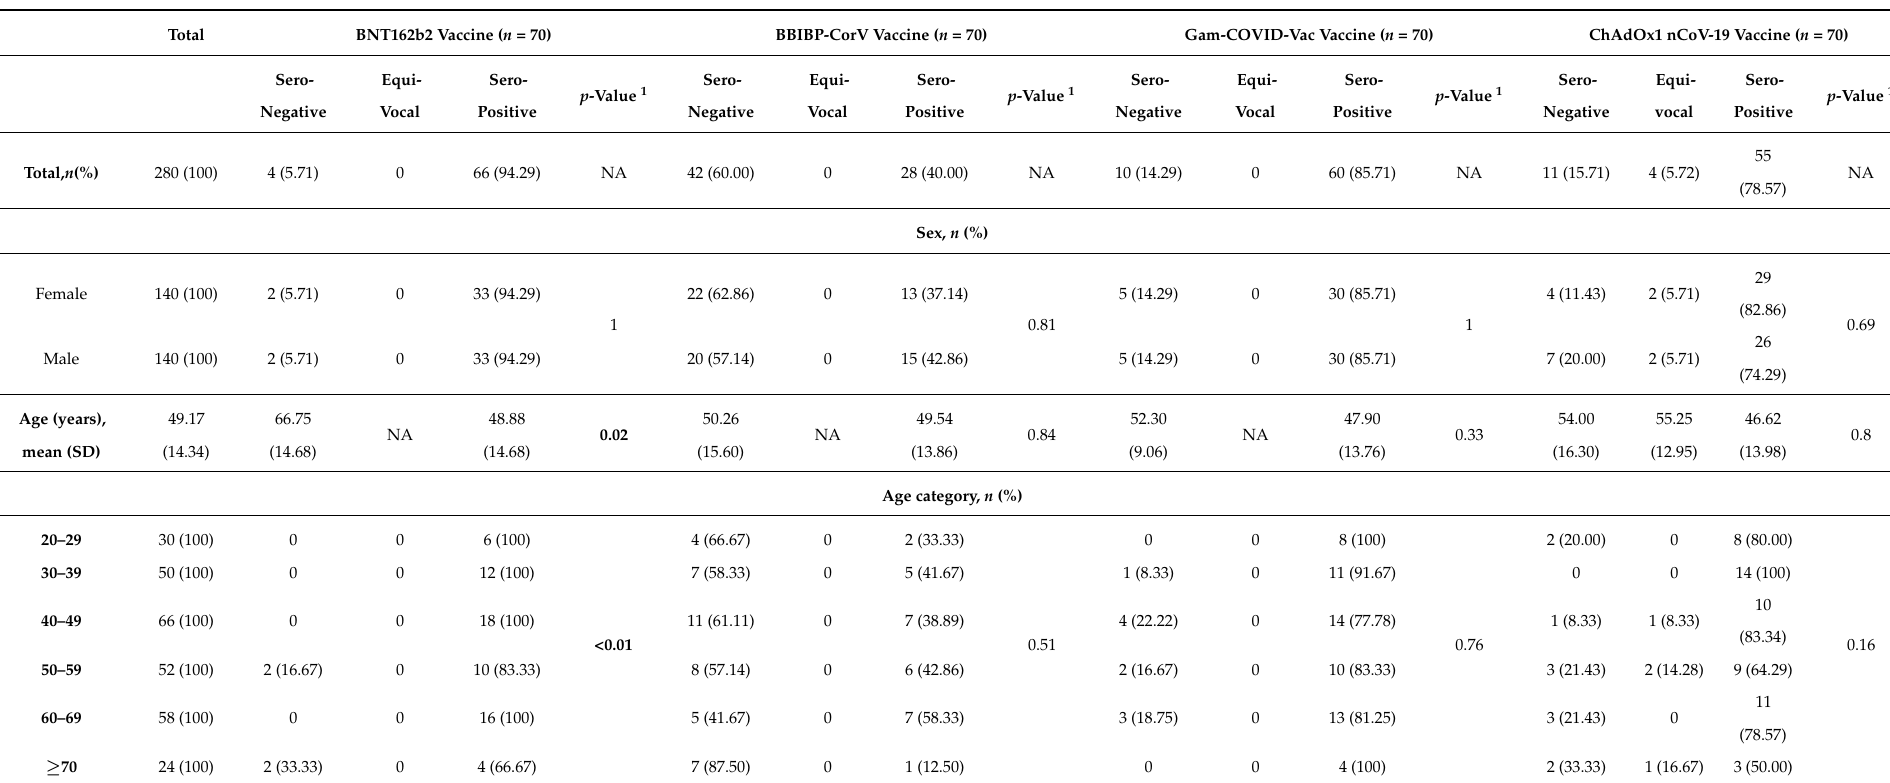
Table 4. Serological profile of the study participants at 6 months from the administration of the second dose of four different SARS-CoV-2